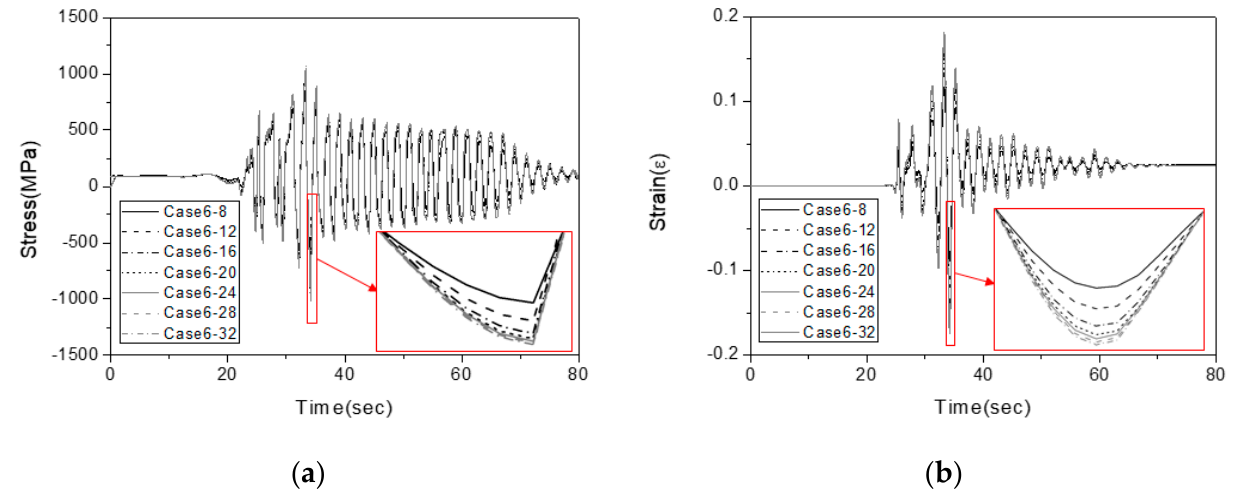
( a ) ( b ) Figure 12. Comparison according to the change in the circumferential element size: ( a ) stress; ( b ) strain. Table 6. Comparison of the maximum stress in the piping system.